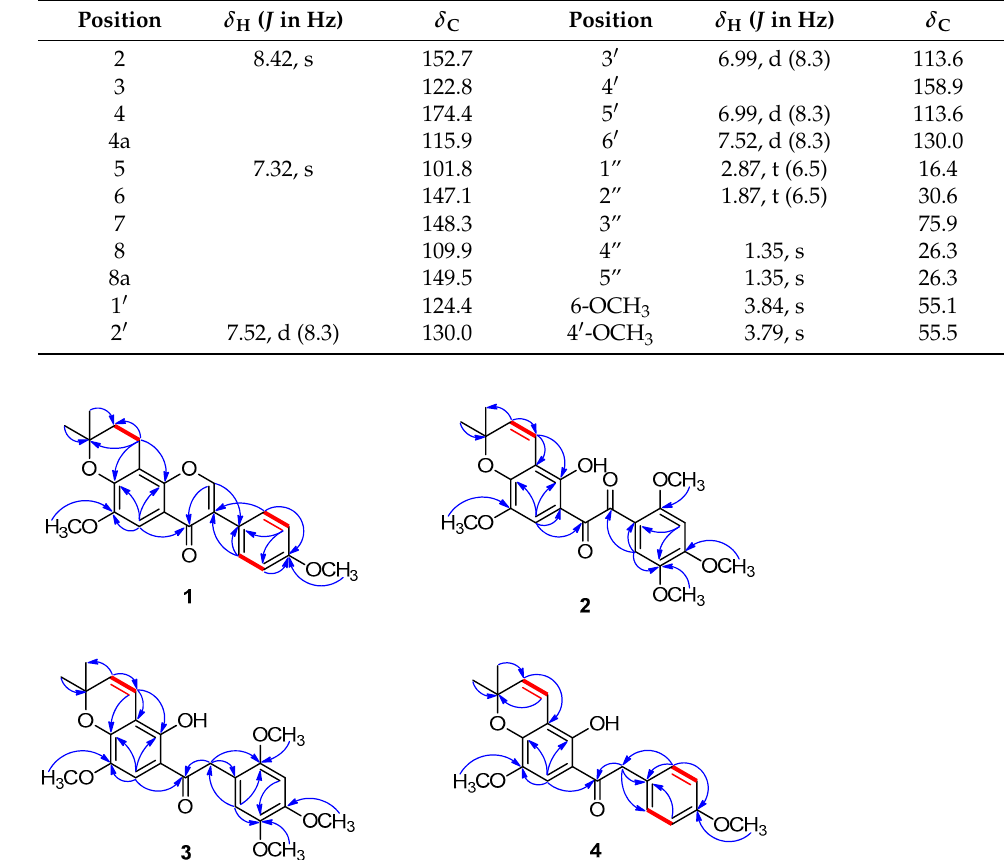
Table 1. 1 H (500 MHz) and 13 C (125 MHz) NMR spectroscopic data of 1 recorded in DMSO- d 6 ( δ in ppm).